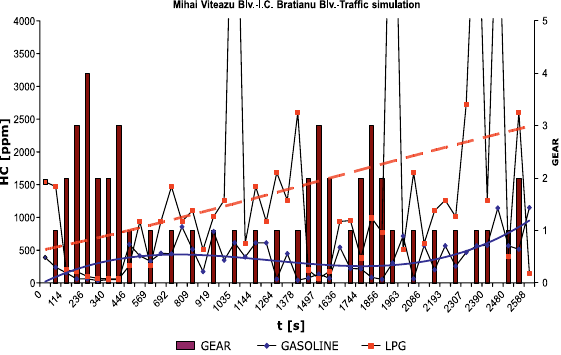
Fig. 16. Compared HC emission versus time (air conditioning unit is turned off) for petrol/LPG